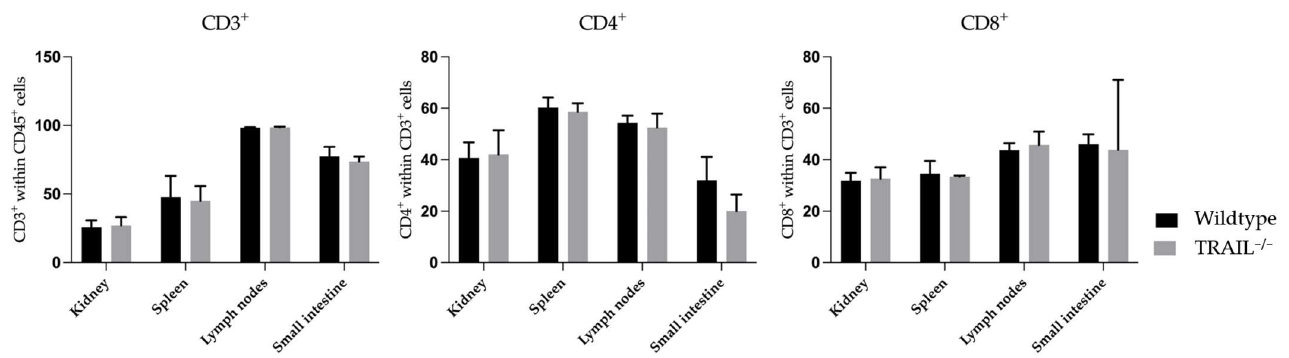
Figure 4. Histogram compares means of frequencies ± SEM of CD3, CD4, and CD8 T-cells in the kidney, spleen, lymph nodes, and small intestine of TRAIL −/− mice versus wildtype C57BL/6 mice ( t -test for CD3 and CD4, Mann-Whitney test for CD8, n = 6–7 per group). In addition to the two TRAIL receptors that have a functional death domain and can thus, induce apoptosis (DR4 and DR5), other TRAIL receptors exist that act as decoy re- ceptors. These include TRAIL receptor 3 (DcR1), which has no intracellular domain, and the functionally inactive TRAIL receptor 4 (DcR2) [24]. In this study, we found signifi- cantly increased frequencies of DR5 (* p < 0.05) on CD3-lymphocytes in the murine TRAIL −/− spleen. In contrast, we observed a decreased expression of the functionally inac- tive DcR2 receptor in TRAIL −/− (* p < 0.05) (Figure 5). We observed no significant differences in the presence of central memory CD4 + and CD8 + cells (Figure 6). Next, we explored the distribution of CD4 + and CD8 + (CD62 low CD44 high ) effector memory cells and found that these lymphocyte subtypes are more pronounced in the spleen in of TRAIL −/− mice (Figure 7). Next, we examined the frequencies of Tregs in lymphatic and non-lymphatic organs. We observed a tendency towards accumulation of Tregs in the kidney, spleen, lymph nodes, and small intestines of TRAIL −/− mice versus wildtype C57BL/6 mice; however, it was not significant (Figure 8). CD8 + CD122 + T-cells belong to a central-memory regulatory T-cell subset. They are known to exhibit potent suppressant functions towards auto- as well as alloimmunity [25]. We found an increased number of CD8 + CD122 + T-cells in the kidney (* p < 0.05) and spleen (not significant, p = 0.157) of TRAIL −/− mice. Interestingly, we detected a decreased pres- ence of CD8 + CD122 + T-cells in the TRAIL −/− small intestine (Figure 9). We analyzed the proliferation capacity of wildtype and TRAIL-deficient CD3 + lym- phocytes. We isolated CD3 + lymphocytes from the splenocytes using MACS and verified the isolation purity via FACS. The proliferation was analyzed after 72 h of stimulation with CD3/CD28 using FACS. Our findings suggest that wildtype CD3 + lymphocytes pro- liferate at a significantly higher rate ( p = 0.037) compared to the TRAIL-knockout lympho- cytes (Figure 10). The gating strategy to identify CFSE-based proliferation of CD4 + T cells is depicted in Supplemental Figure S3.